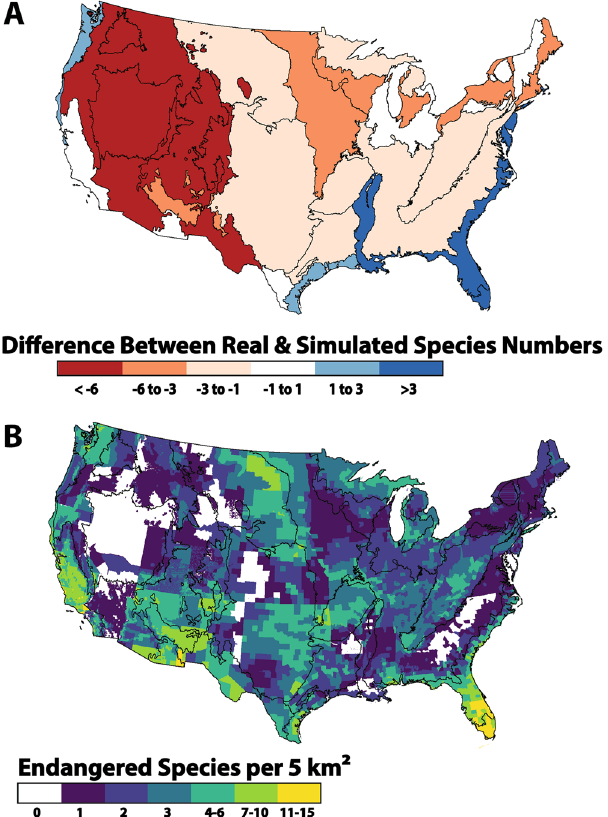
Figure 1. Null modeling results and endangered species richness within the USA. (a) Difference between the current number of endangered species with any part of their range inside highly protected areas and the average results of 1,000 random placements of those highly protected areas. Warm colors show regions that performed worse than a random placement, while cool colors indicate regions that performed better than random. Ecoregion data were obtained from The Nature Conservancy 34 . (b) Number of endangered tetrapod species per 5 km 2 pixel, species distribution data were obtained from The USFWS Environmental Conservation Online System 47